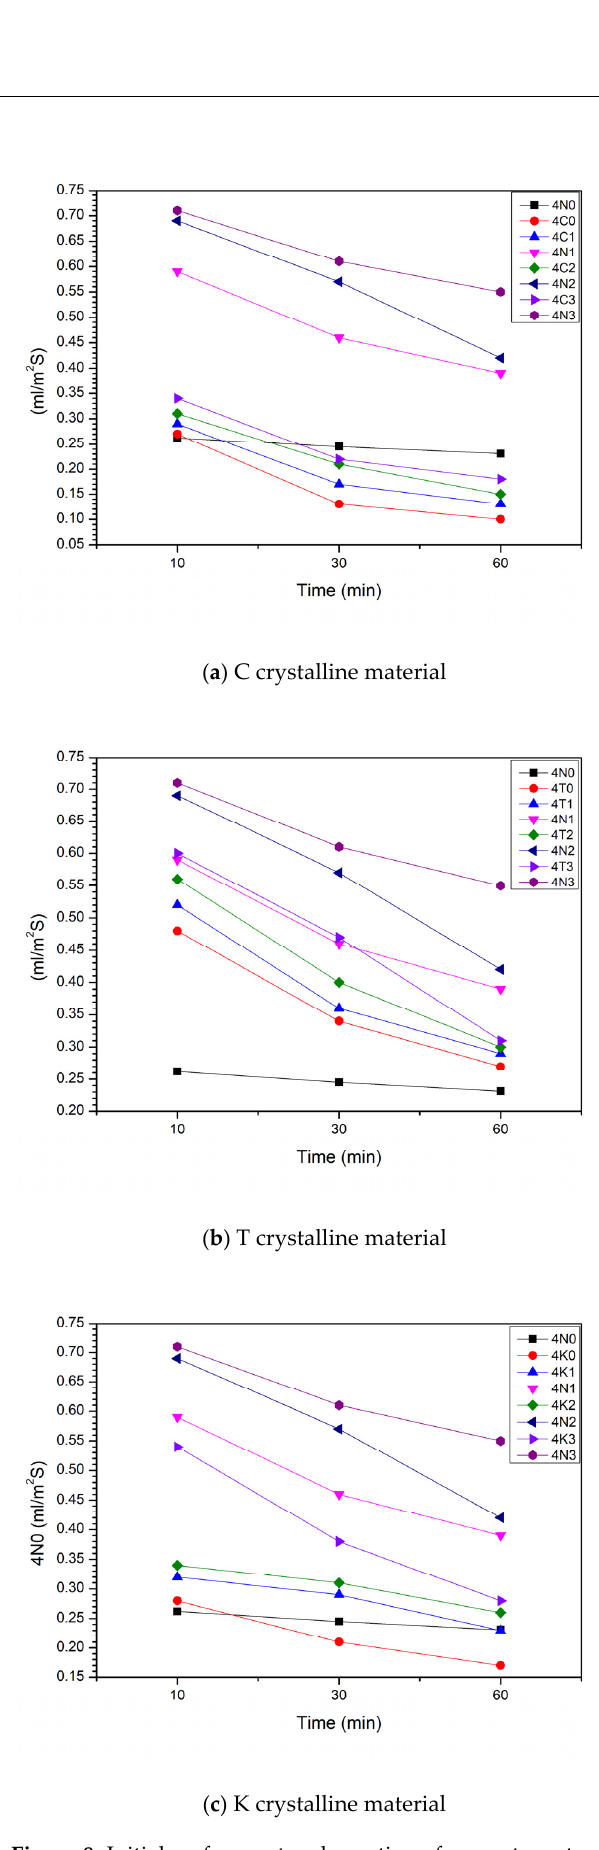
Figure 8. Initial surface water absorption of cement mortar after 28 days when W/C = 0.4.